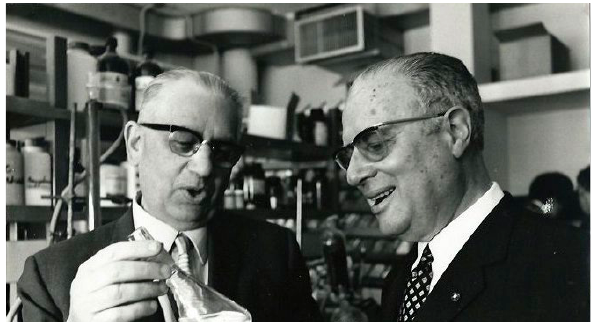
Figure 6. Zvi (left) with Alberto Casali; (from the private collection of the Jolles-Bainbridge family, now in the Fondo Jolles at Florence University Museum of Natural